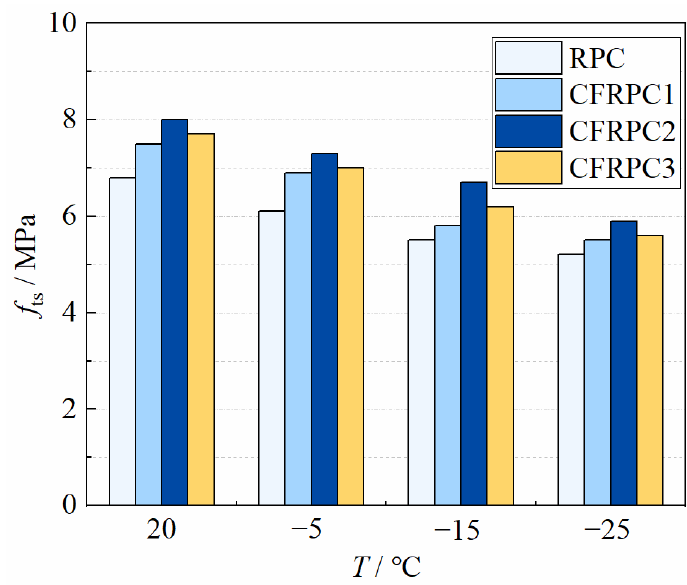
Figure 16. Relationship f ts vs. T.